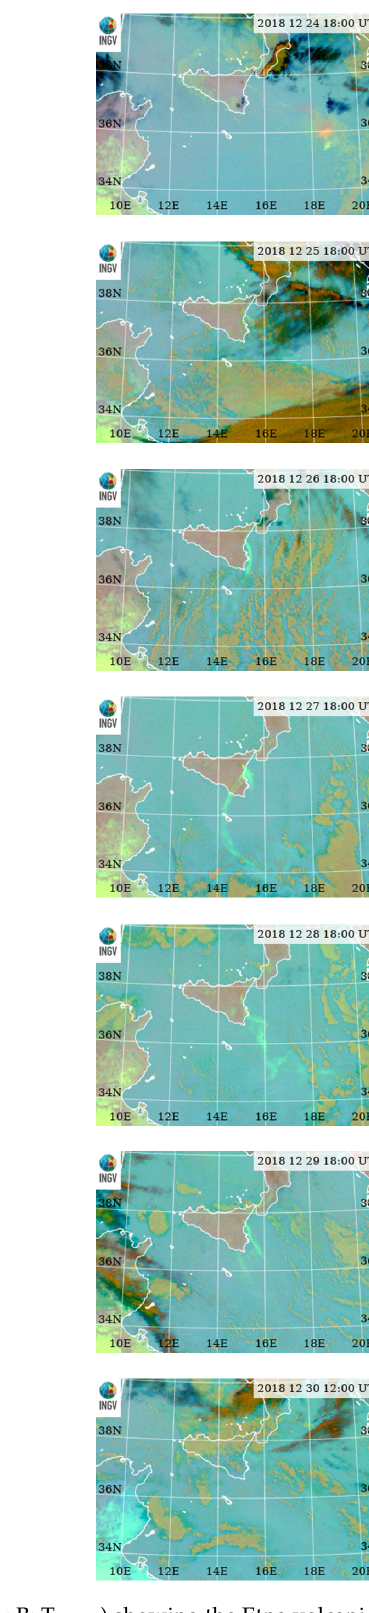
Figure 2. RGB composite (R: T b,8.7 –T b,10.8 ; G: T b,12 –T b,10.8 ; B: T b,10.8 ) showing the Etna volcanic cloud detection considering several Spinning Enhanced Visible and InfraRed Imager (SEVIRI) images collected from 24 to 30 December 2018. The prevalence of red and green colors identify ash and SO 2 ,